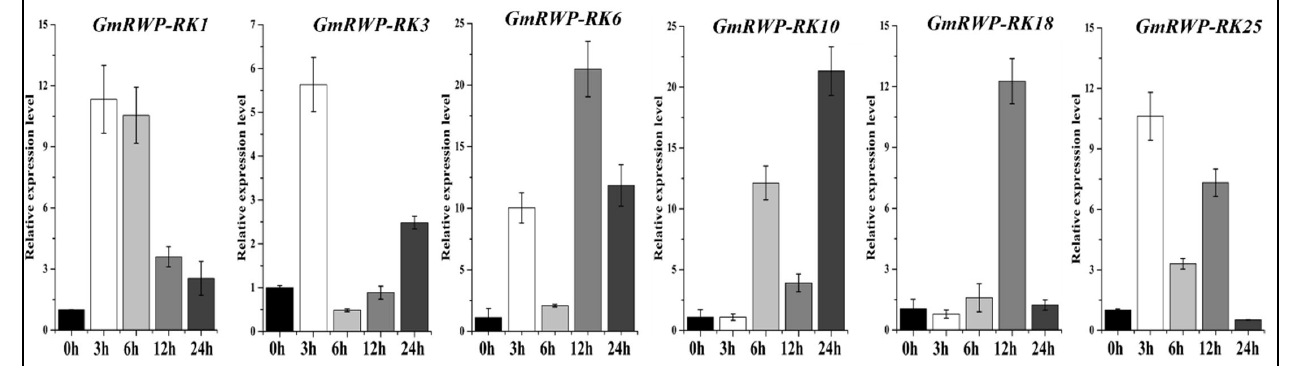
Figure 8. Relative expression level of GmRWP ‐ RK genes under nitrogen application at different time periods using qRT ‐ PCR analysis. The different colored bars represent different time periods from (0–24 h). Error bars show the ±SE from three independent biological replicates.